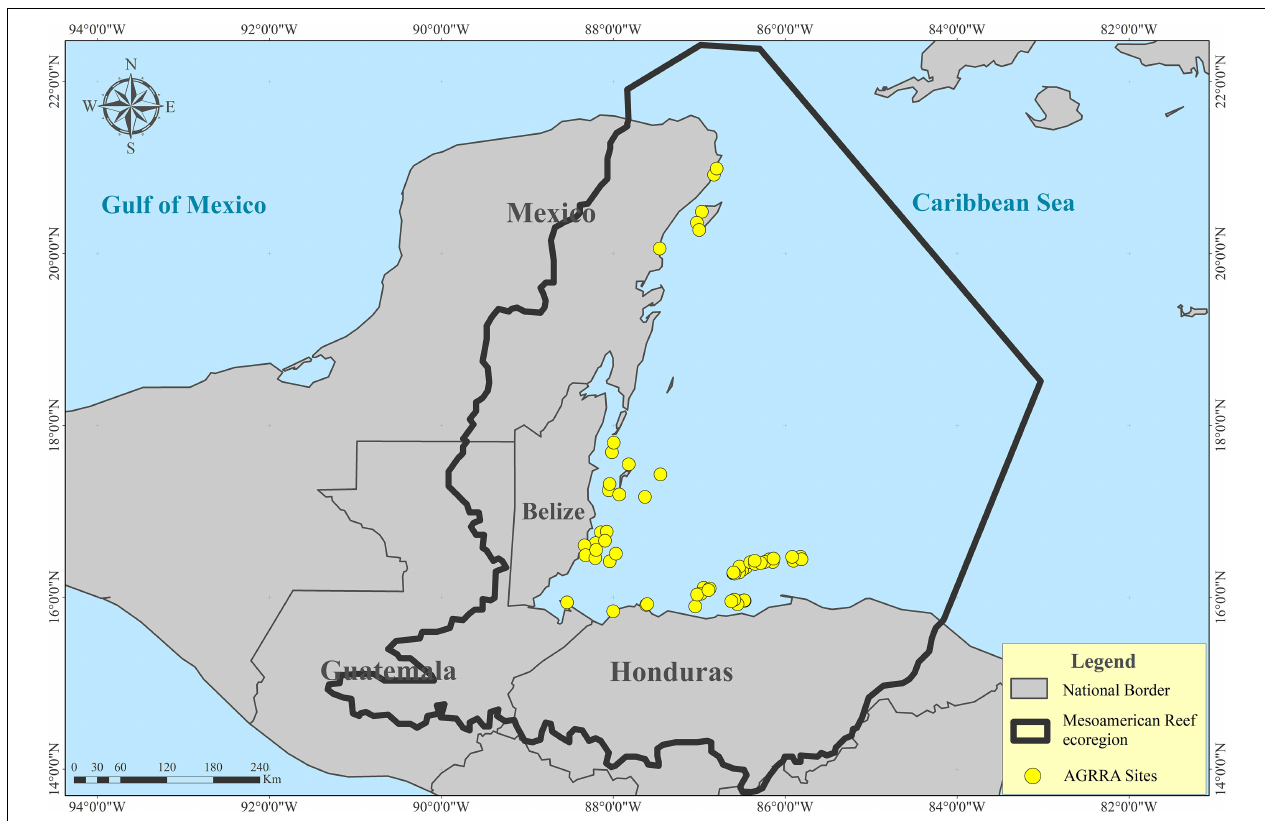
FIGURE 2 | Sites selected ( n = 64) in the Mesoamerican Reef ecoregion based on two criteria: (1) their live coral cover was higher than 10% in 2006 and (2) they were monitored both in 2006 and in 2016 by the Healthy Reefs